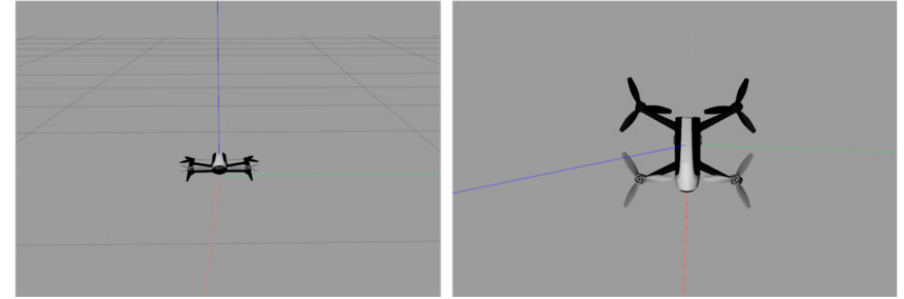
Figure 4. The model of quadrotor aircraft in the Gazebo simulation environment.